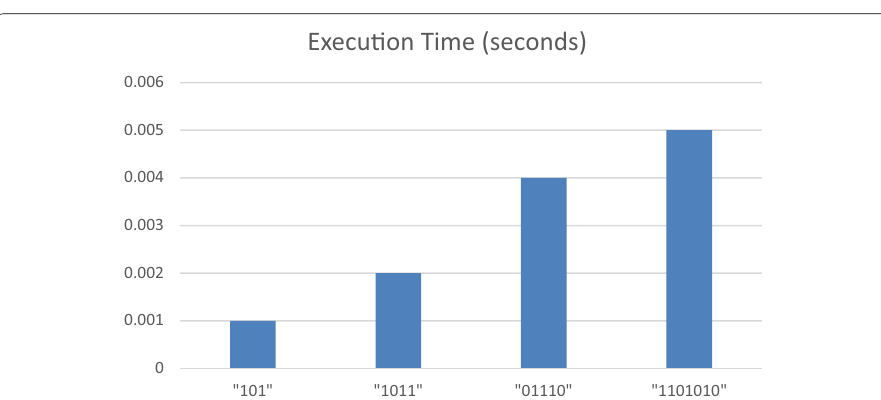
Fig. 26 Execution times of classical bit strings—right or anticlockwise rotation